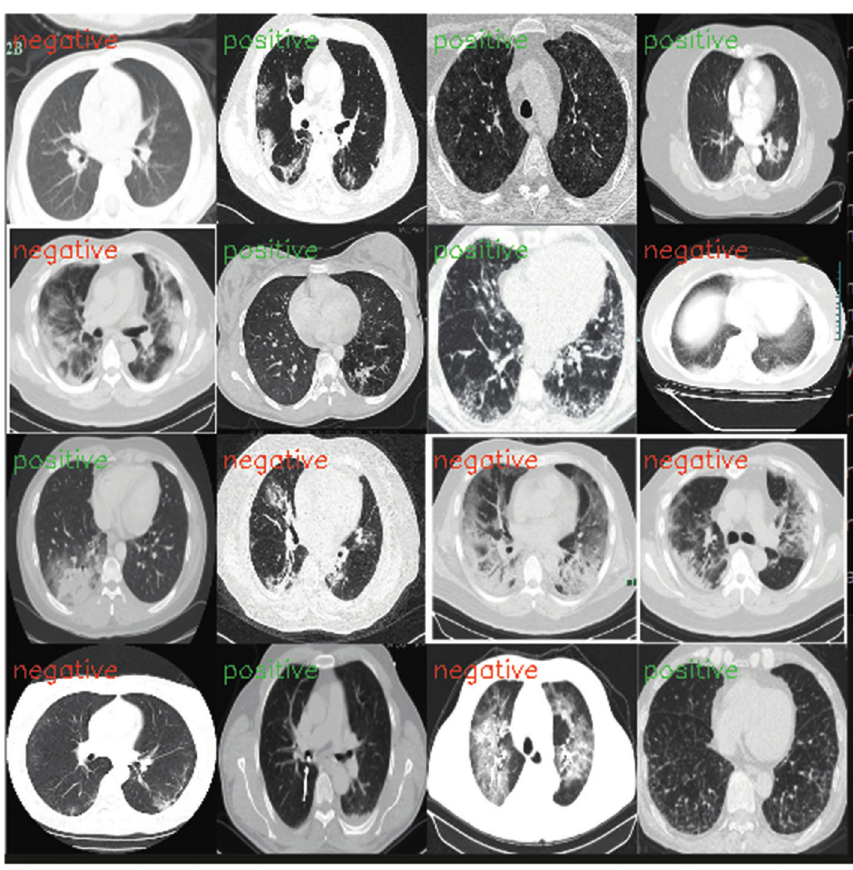
Figure 9: Tested VGG19 model. Table 7: Performance of VGG19 network based on combined dataset.